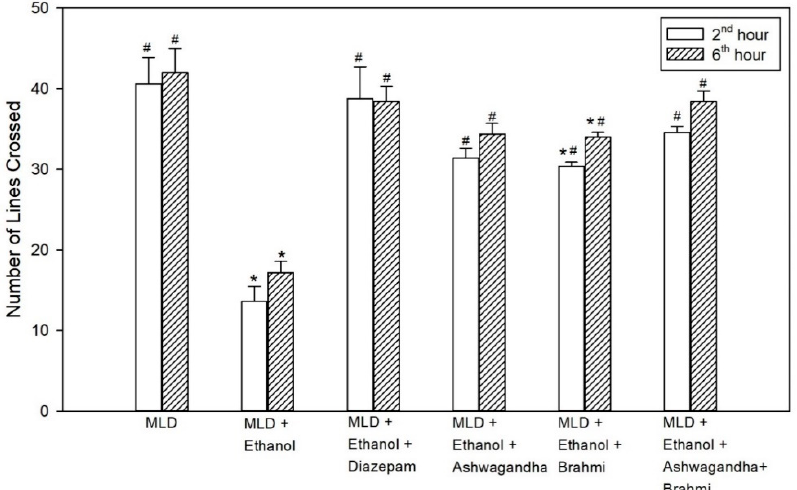
Figure 5. Effect of test drugs on locomotor activity represented by the number of lines crossed in open field test at 2nd hour and 6th hour of alcohol withdrawal. (‘*’ represents statistically significant compared with MLD group. ‘#’ represents statistically significance compared with MLD + Ethanol group).